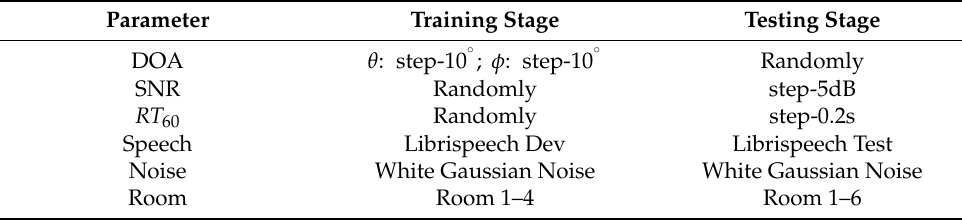
Table 2. Parameters for the simulated